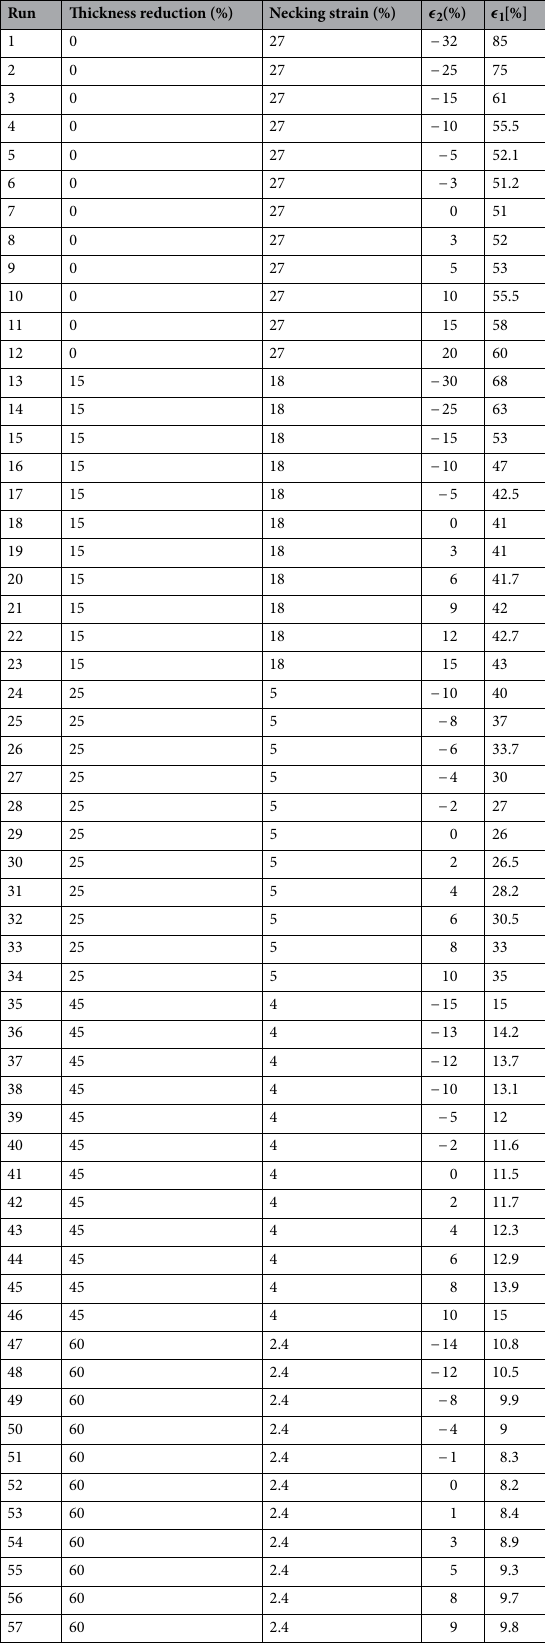
Table 2. Input and output data based on experimental